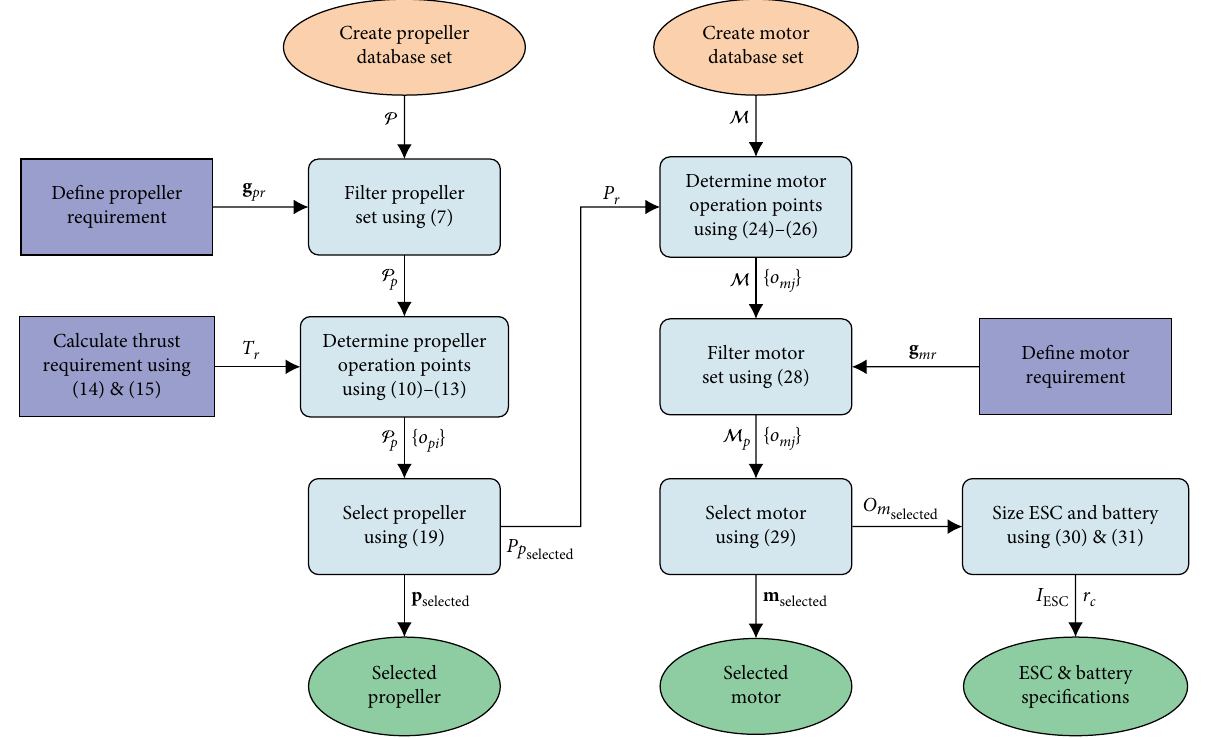
Figure 6: Actuating system sizing methodology information flow diagram.